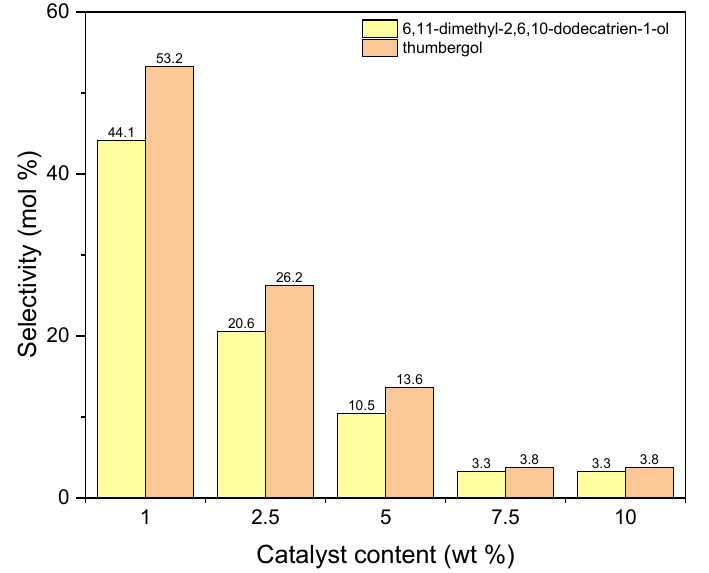
Figure 11. The influence of catalyst content on the selectivities of the appropriate products over diatomite as the catalyst.